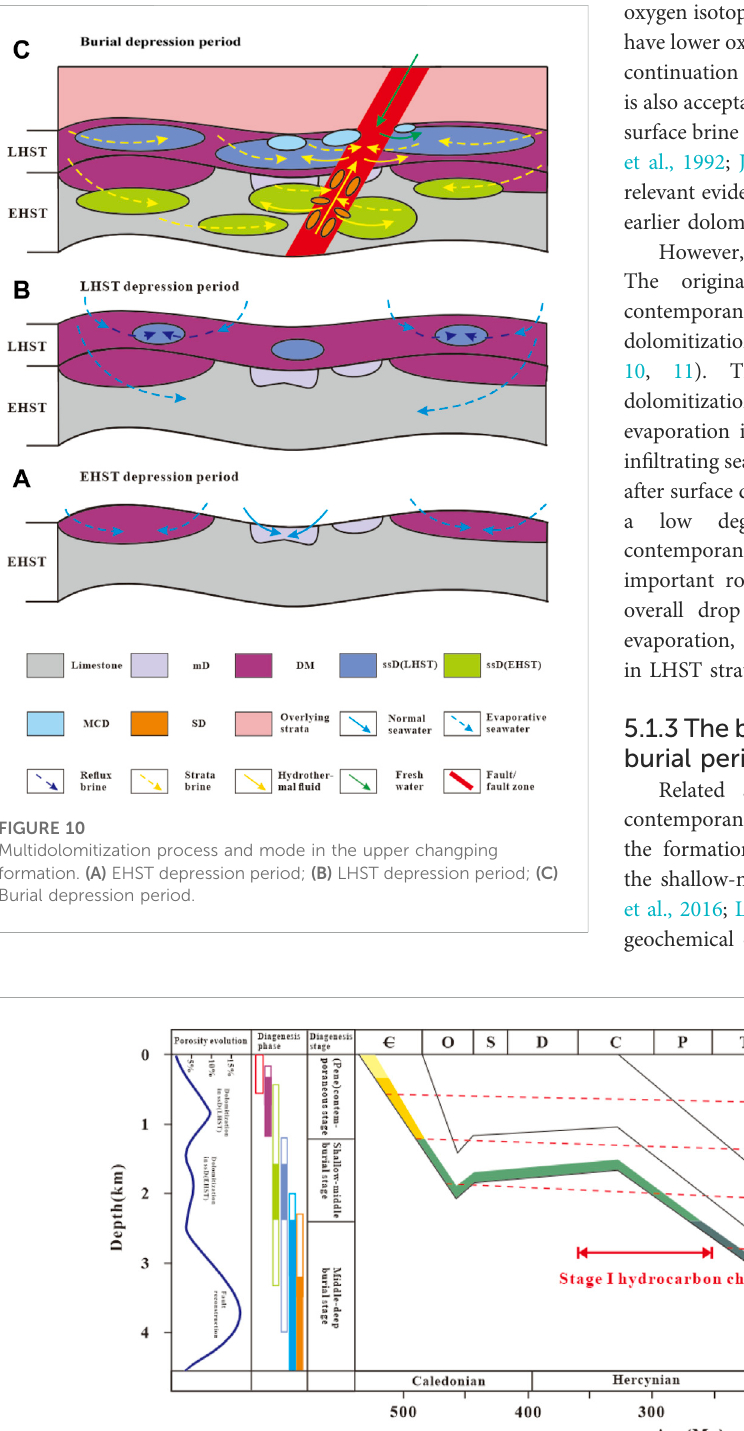
Frontiers in Earth